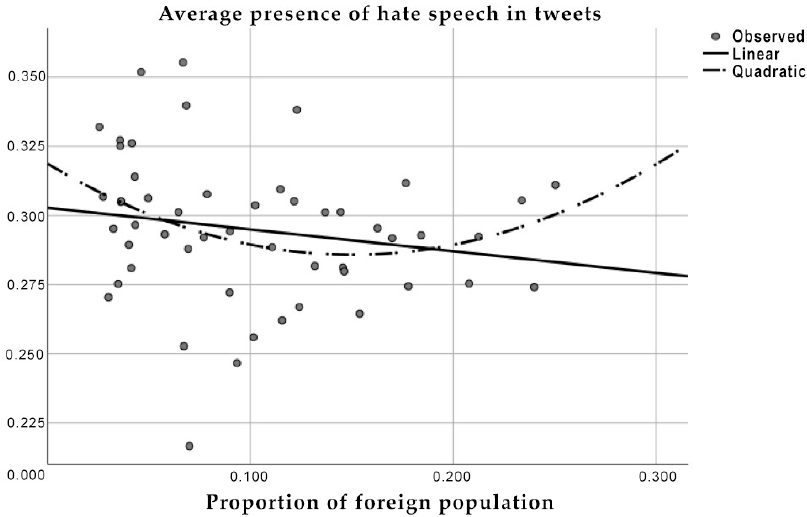
Figure 5. Average presence of hate speech against migrants and refugees on Twitter in Spain by provinces and years. Own elaboration.